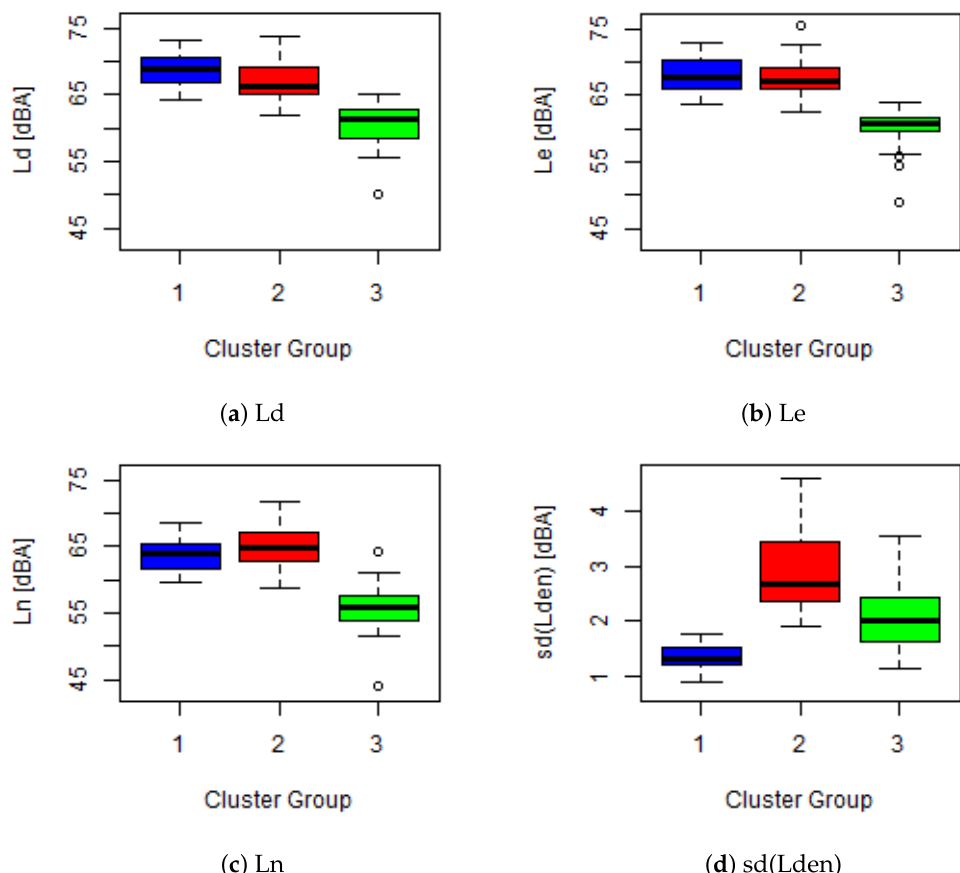
Figure 3. Boxplot representation of the statistical distributions of the variables L d2019 ( a ), L e2019 ( b ), L n2019 ( c ) and sd 2019 ( L den1 d ) ( d ) by cluster for k = 3. Hierarchical Agglomeration clustering model. Clusters groups are colored as presented in Table 6.